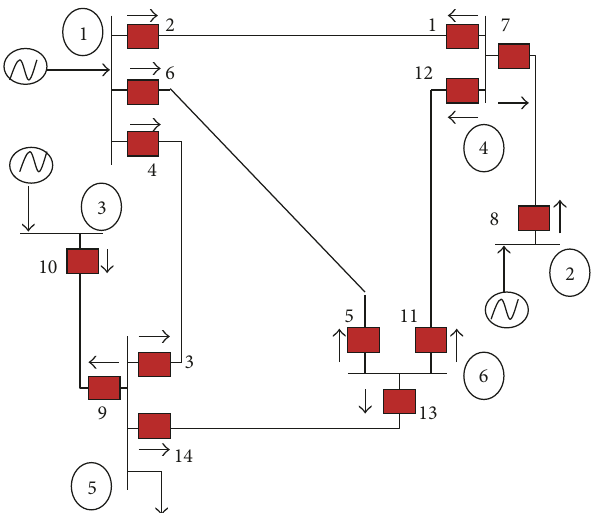
Figure 10: Model for the IEEE 6-bus